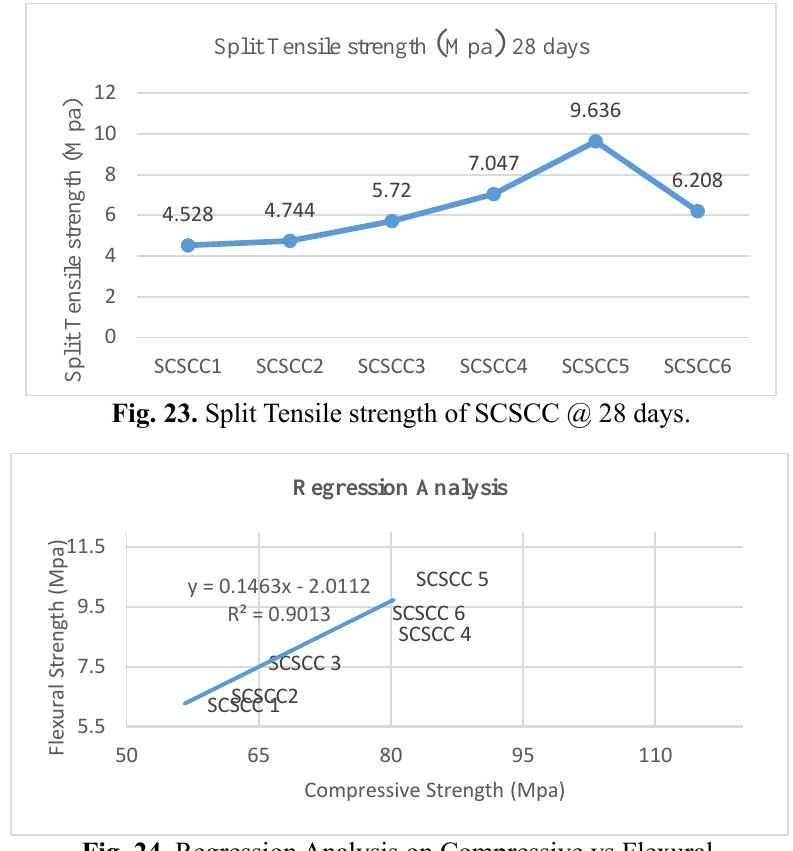
Fig. 24. Regression Analysis on Compressive vs Flexural.